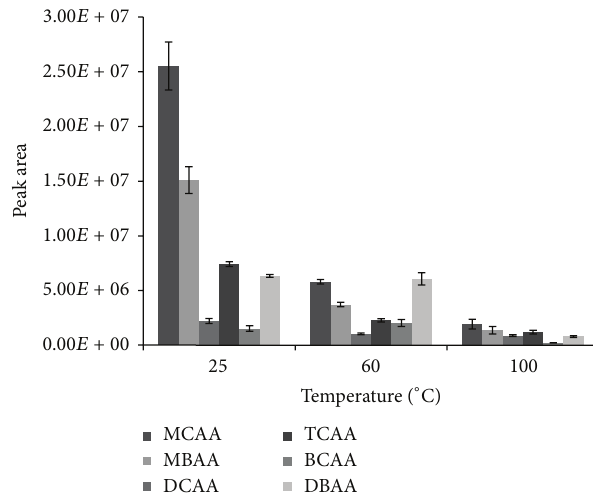
Figure 1: Effect of temperature on the simultaneous liquid-liquid microextraction and derivatization of 0.5 𝜇 gL −1 haloacetic acids at experimental conditions of 5 min reaction time, 5 𝜇 L TFAA as catalyst, and 1mL 𝑛 -octanol as both extractant solvent and derivatization reagent.